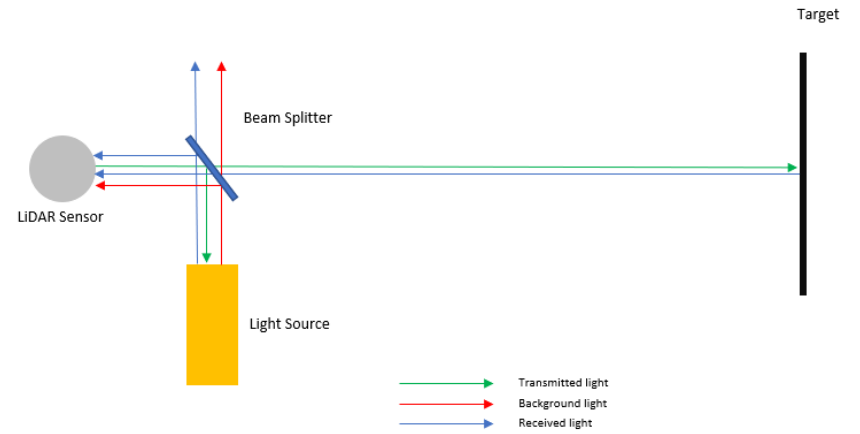
Figure 7. Experimental setup for background light influence.